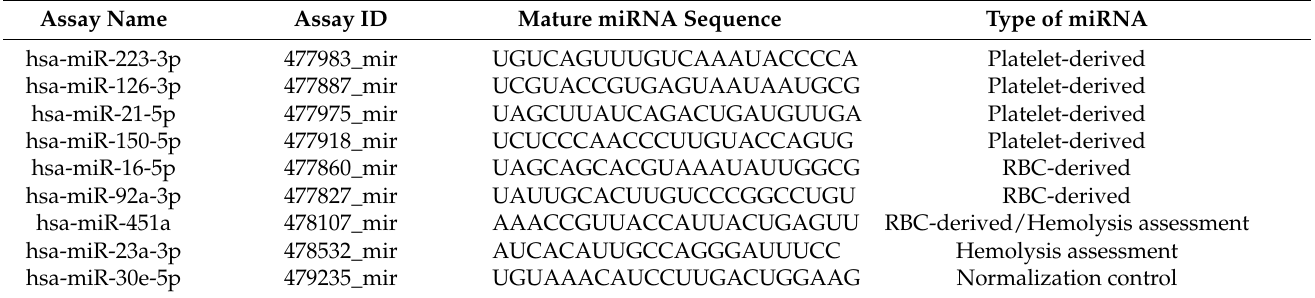
Table 2. List of the miRNA assays used for